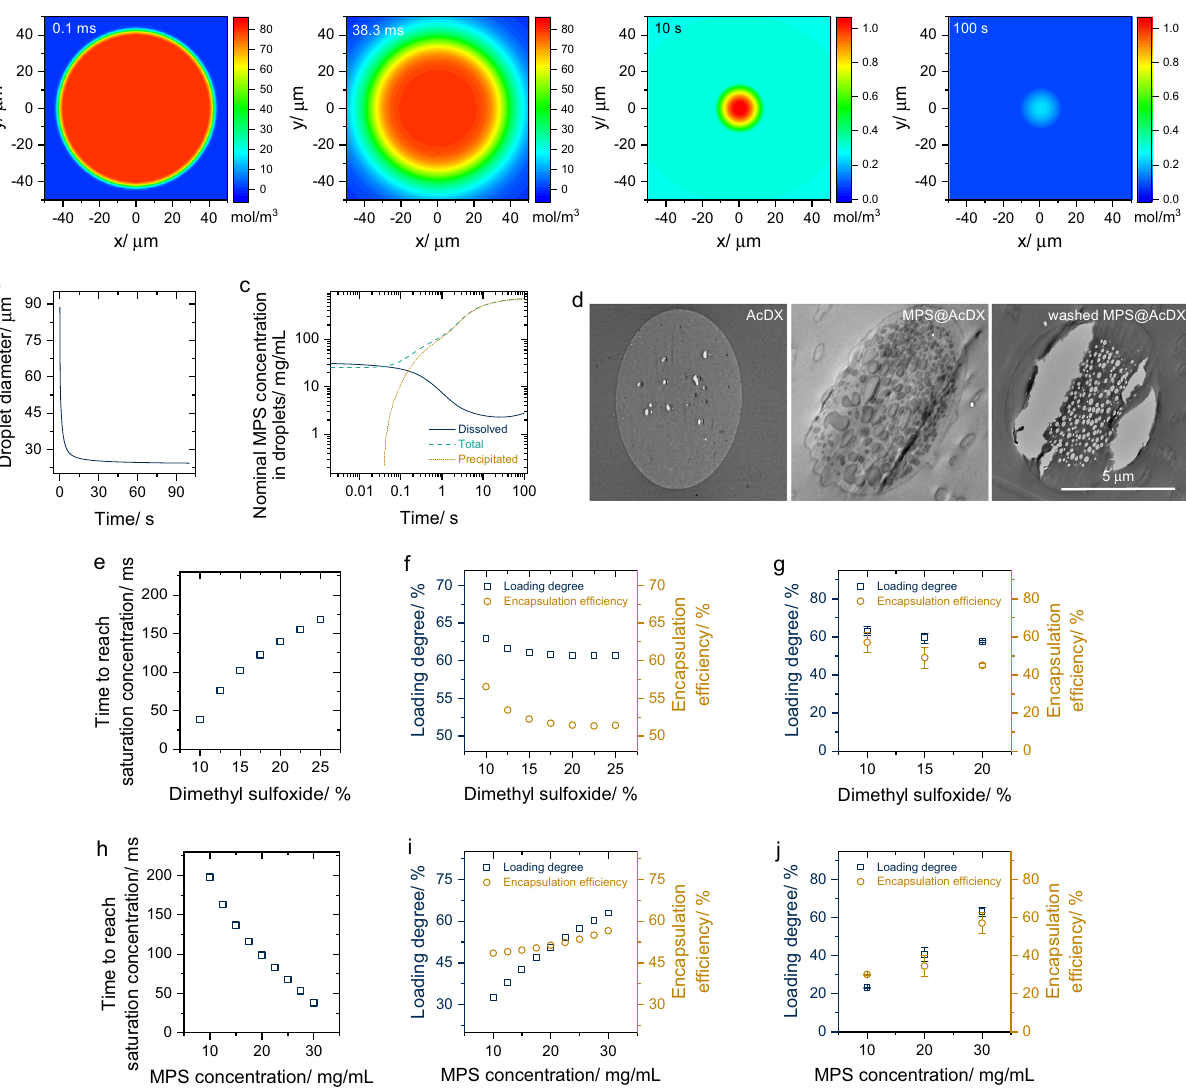
Fig. 3 Numerical simulation of the droplet solidi fi cation and drug encapsulation. a Concentration fi elds of MPS on the mid-plane of the droplet. The color bar on the right side represents the concentration magnitude of MPS. b The shrinking of a droplet as a function of time during the solidi fi cation process. c Nominal concentration (mass of drug divided by volume of droplet) of MPS at different states (dissolved and precipitated) in the droplet during the solidi fi cation process. d Transmission electron microscope images of thin section of bare AcDX, MPS@AcDX, and washed thin section of MPS@AcDX. e The impact of initial dimethyl sulfoxide ratio in the inner fl uid on the simulated diffusion time that taken for MPS to reach the saturation concentration in droplets. f , g Numerically simulated ( f ) and experimental ( g ; n = 3) loading degree and encapsulation ef fi ciency of AcDX microspheres prepared by varying the dimethyl sulfoxide ratio in the inner fl uid. AcDX concentration and MPS concentration are set at 10 mg/mL and 30 mg/mL, respectively. Data are presented as mean values ± SD. h The impact of initial MPS concentration in the inner fl uid on the numerically simulated diffusion time that taken for MPS to reach saturation concentration in the droplets. i , j Numerically simulated ( i ) and experimental ( j ; n = 3) loading degree and encapsulation ef fi ciency of AcDX microspheres. AcDX concentration and dimethyl sulfoxide ratio are set at 10 mg/mL and 10% v/v, respectively. Data are presented as mean values ±